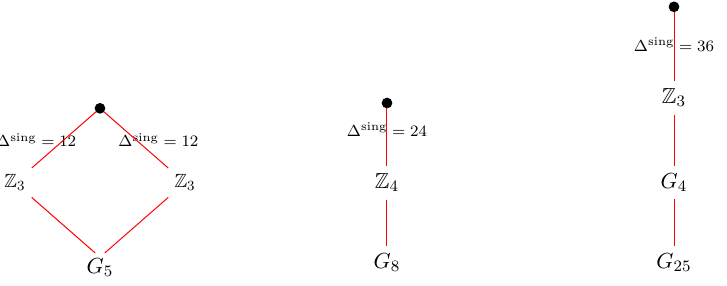
Figure 3 . Hasse diagrams for the moduli spaces of the N = 3 theories obtained from the type- e 6 (2,0)